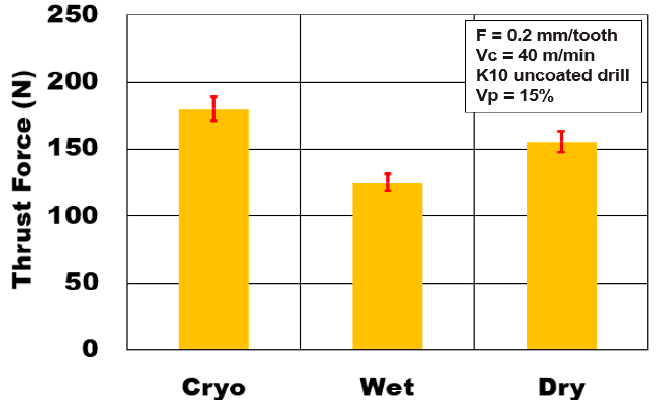
Figure 5. E ff ect of cooling medium on thrust force during plunge drilling of AZ31-alumina Figure 5. Effect of cooling medium on thrust force during plunge drilling of AZ31-alumina syntactic syntactic foam.